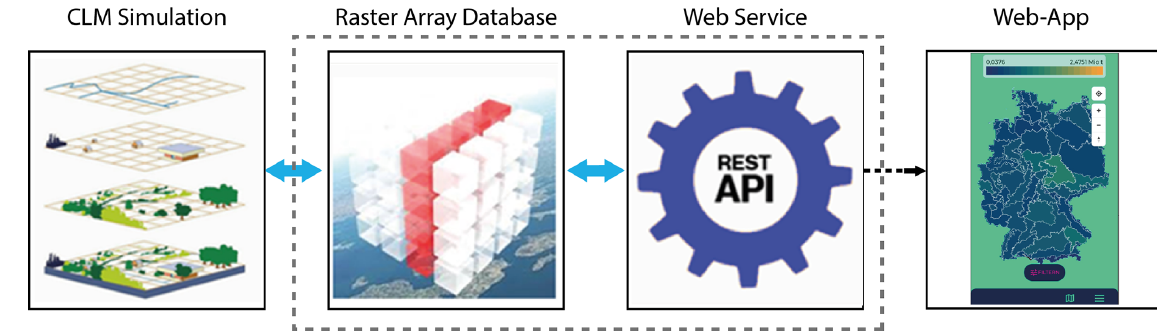
Figure 8. Schematic representation of the data flow components for the Soil Carbon App, from land surface model CLM (left) through the raster array data base and the web service towards the app’s front-end (right) (graphics source: omnisci (land surface model scheme), rasdaman (Raster Array Database), DLR, mulesoft,